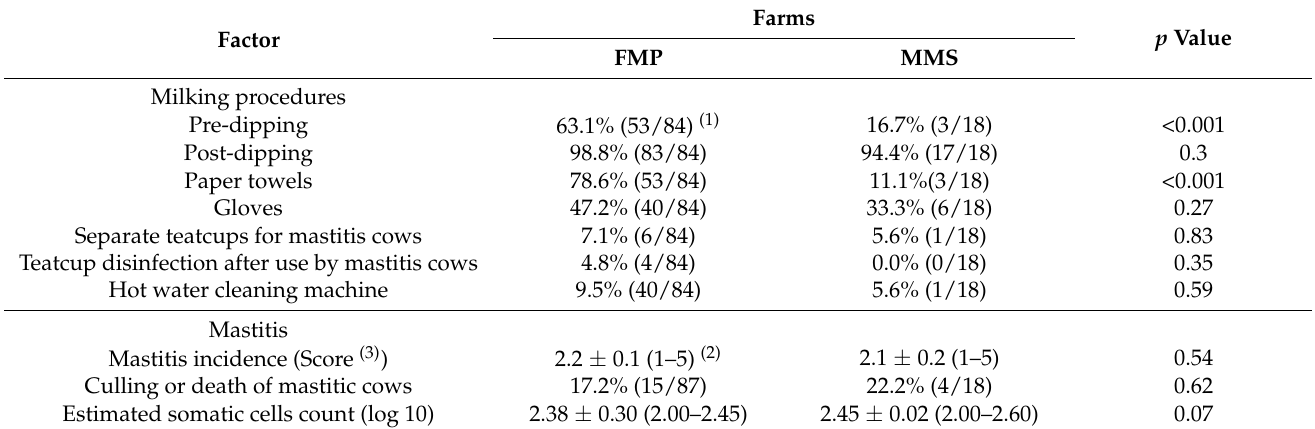
Table 3. Milking procedures and mastitis scores, according to fixed (FMP) or mobile (MMS) milking system